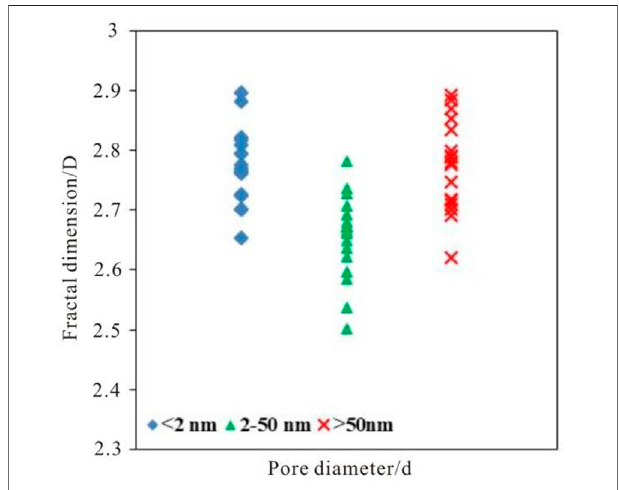
FIGURE 14 | Comparison of different pore diameter fractal dimensions of Shanxi Formation.